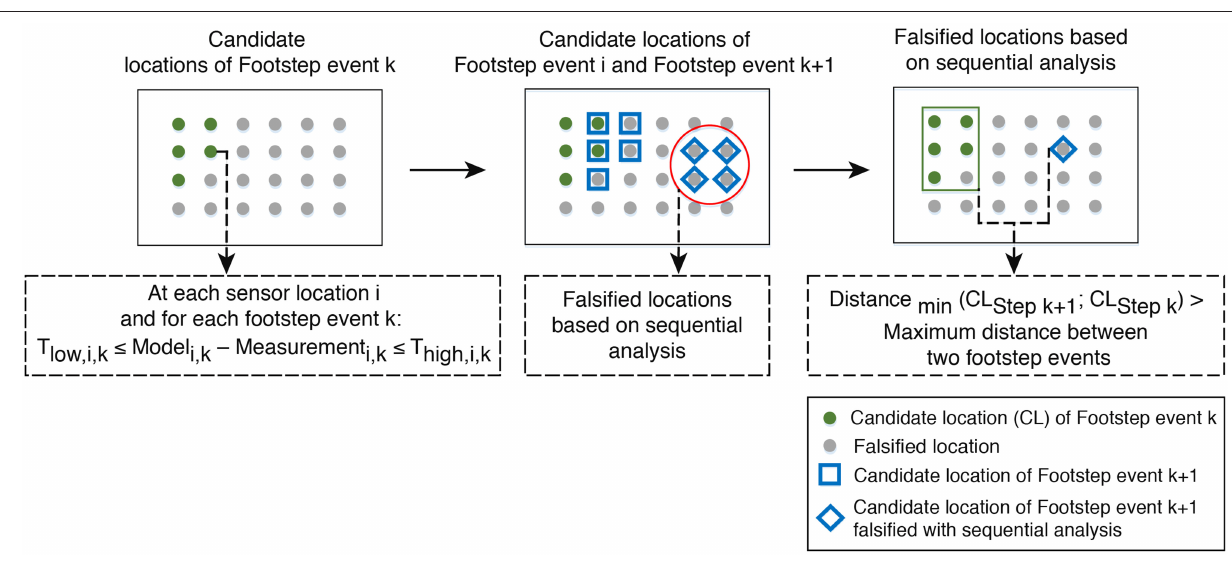
Frontiers in Built Environment |